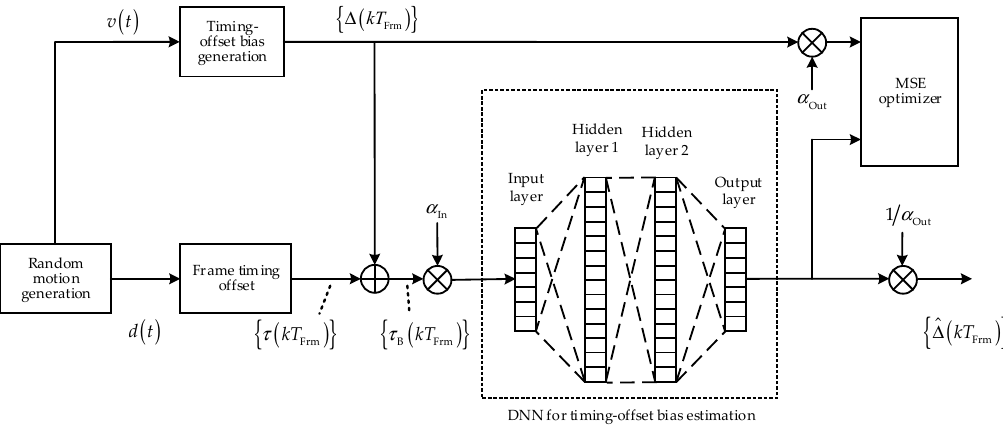
Figure 1. Deep neural network (DNN) training diagram for the timing bias estimation. MSE, mean square error.